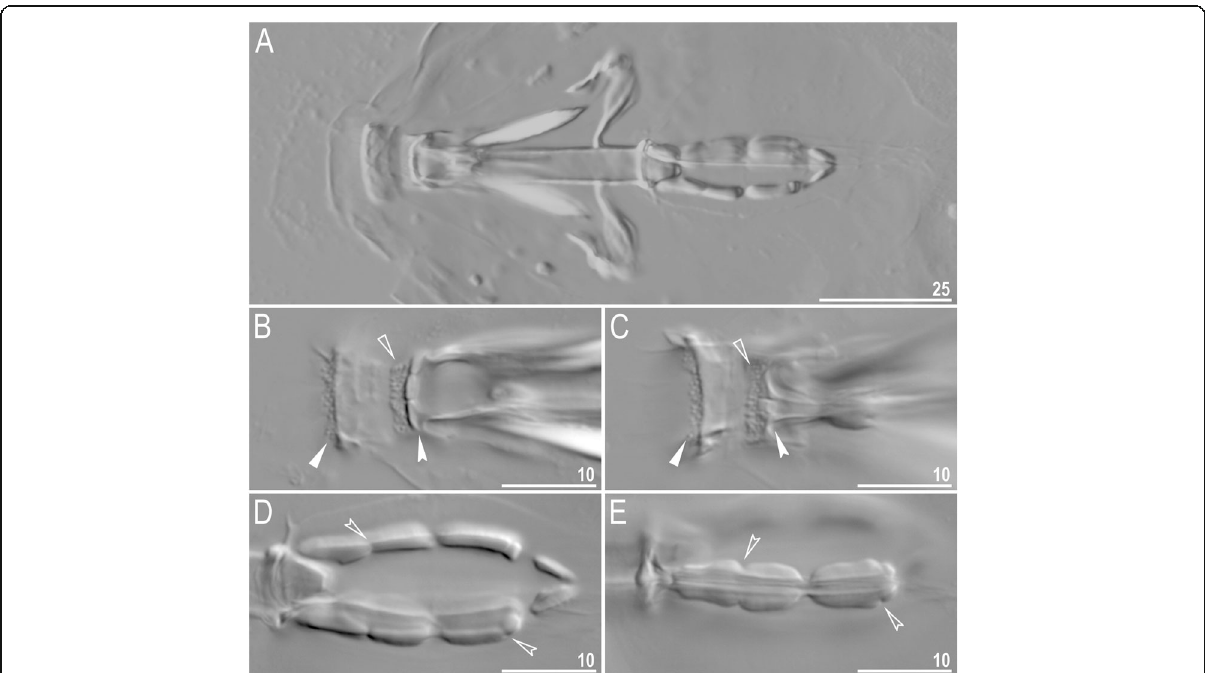
Fig. 7 Macrobiotus pallarii Maucci, 1954 from the topotypic population (IT.337) – buccal apparatus seen with LCM: a – an entire buccal apparatus; b – c – the oral cavity armature, dorsal and ventral teeth, respectively; d – e – placoid morphology, dorsal and ventral placoids, respectively. Filled flat arrowheads indicate the first band of teeth, empty flat arrowheads indicate the second band of teeth, filled indented arrowheads indicate the third band of teeth and empty indented arrowheads indicate central and subterminal constrictions in the first and second macroplacoid. Scale bars in μ m